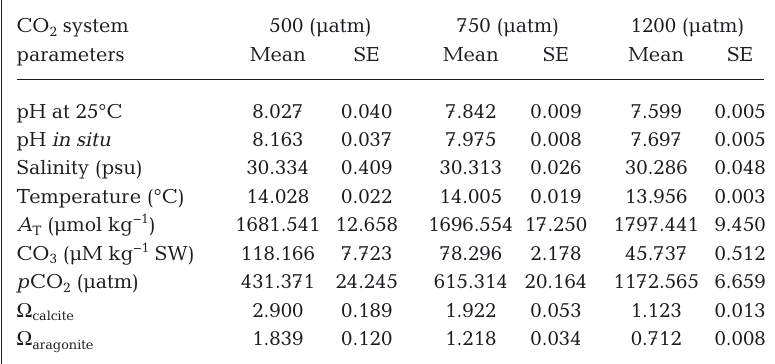
Table 1. Average (±SE) conditions of carbonate system parameters during the experiment conducted with juvenile Choromytilus chorus . pH is reported on the NBS scale; A T : total alkalinity; p CO 2 : partial pressure of CO 2 levels in seawater; CO 32 − : carbonate ion concentration; Ω arag , Ω calcite : saturation states of the water with respect to aragonite and calcite minerals,